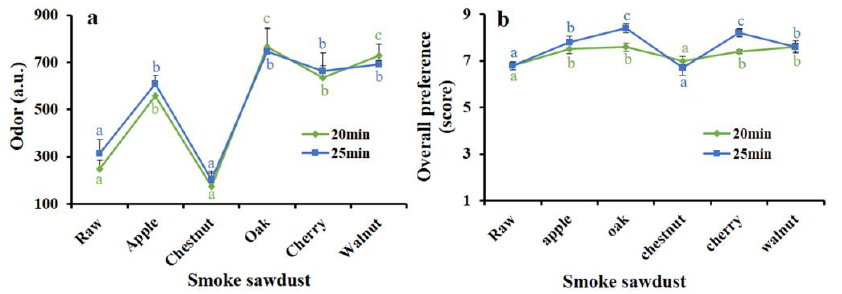
Figure 1. Use of di ff erent sawdust materials on the improvement of sensory attributes of ( a ) odor (a.u.) and ( b ) overall preference (hedonic score) at 20 and 25 min of hot smoking times of half-dried Pacific Saury (HDPS). Data represent the mean ± std of 10 observations, where groups not sharing a letter are expressed as significantly di ff erent ( p <